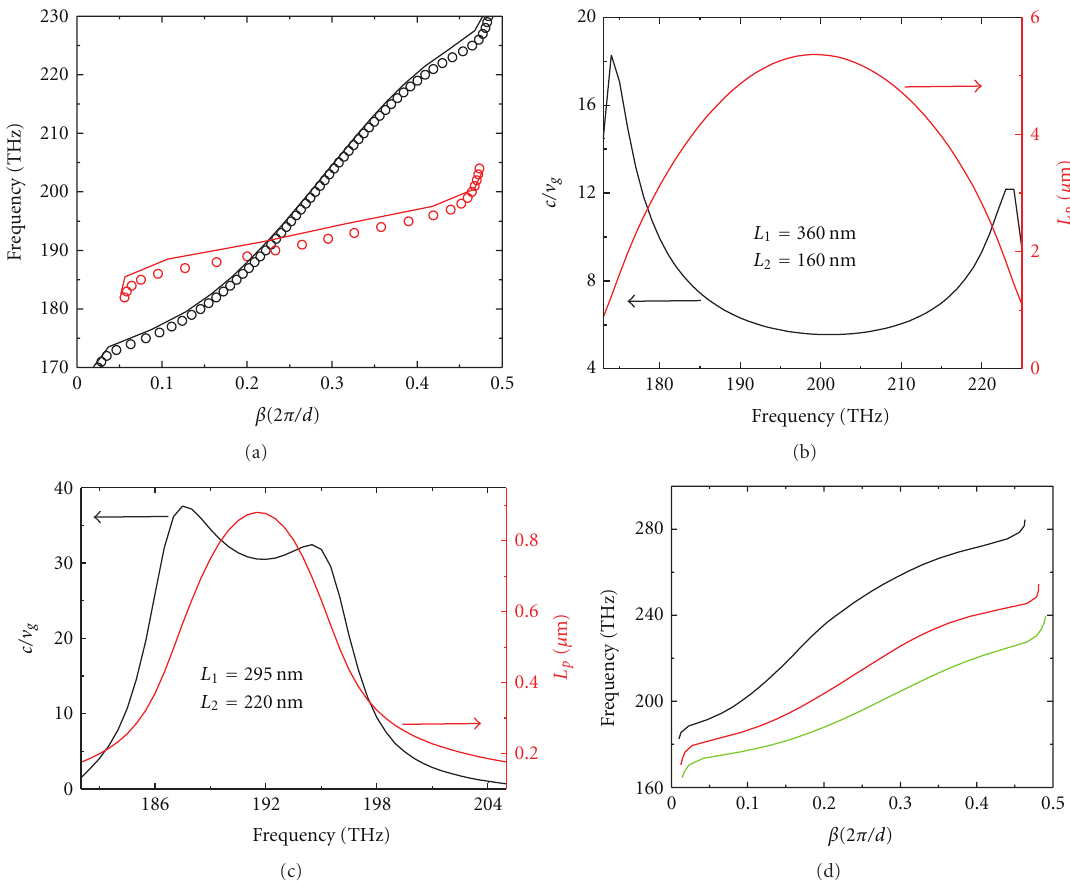
Figure 4: (a) Dispersion relation of the plasmonic waveguide system of Figure 3(a) calculated using FDFD (circles) and scattering matrix theory (solid line). Results are shown for L 1 = 360nm, L 2 = 160 nm (black line and circles) and L 1 = 295 nm, L 2 = 220nm (red line and circles). All other parameters are as in Figure 3(b). In both cases only a portion of the band structure is shown, corresponding to the frequency range of the middle band. ((b)-(c)) Reciprocal of the group velocity v g and propagation length L p for the plasmonic waveguide system of Figure 3(a) as a function of frequency calculated using FDFD. Results are shown for L 1 = 360 nm, L 2 = 160nm and L 1 = 295 nm, L 2 = 220 nm. All other parameters are as in Figure 3(b). (d) Dispersion relation of the plasmonic waveguide system of Figure 3(a) calculated using FDFD. Results are shown for d = 100nm (black line), d = 200nm (red line), and d = 300 nm (green line). All other parameters are